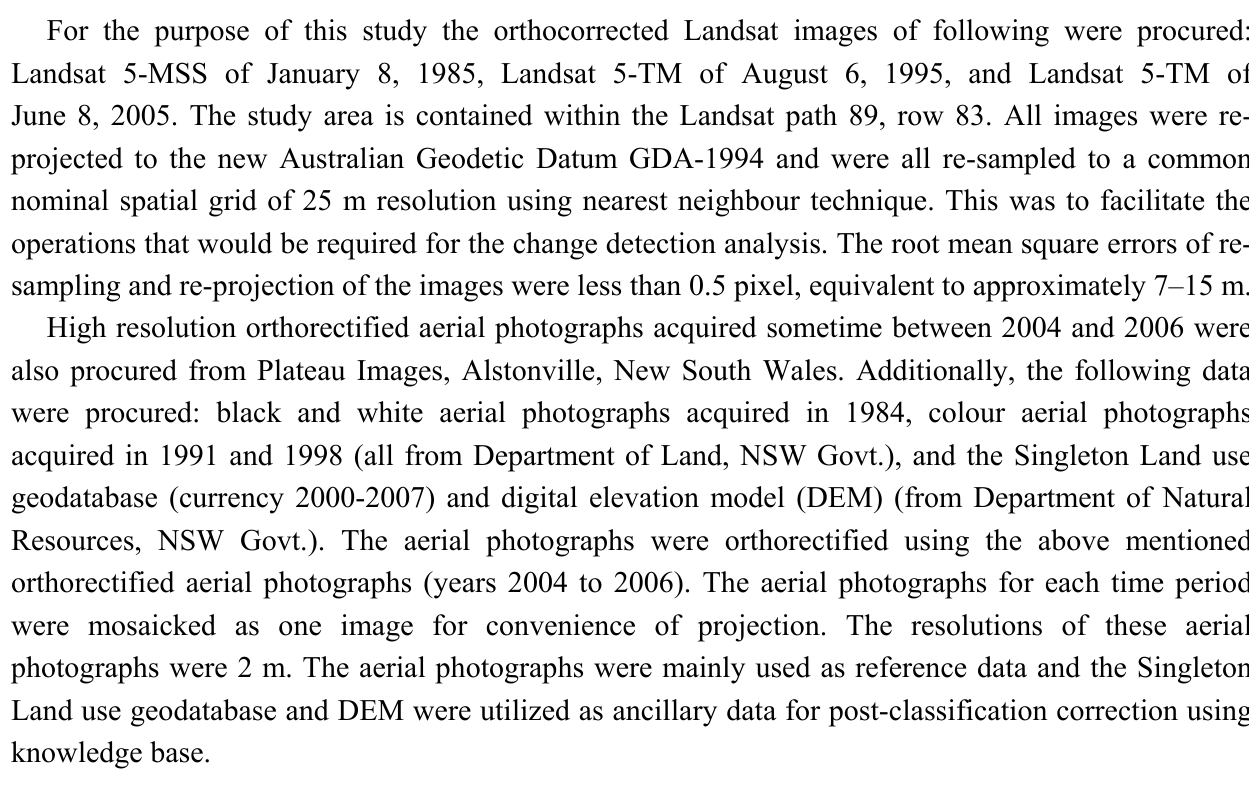
Table 1. LULC categories delineated for the